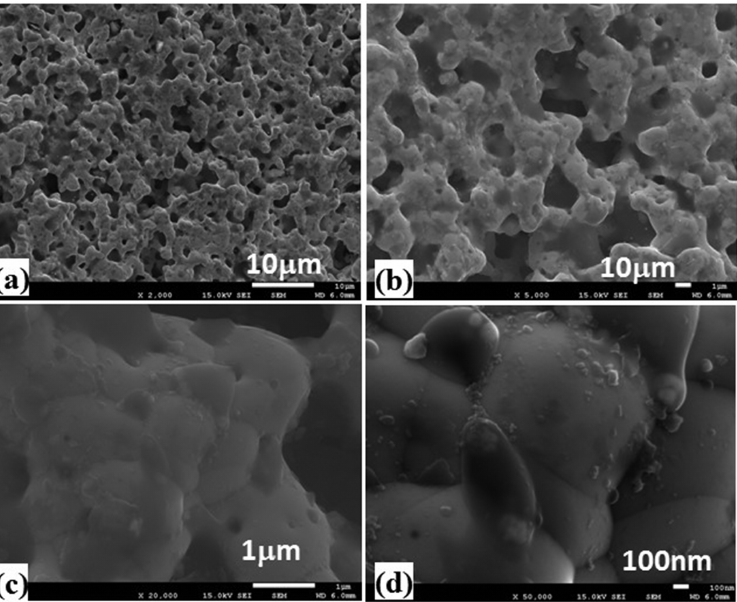
Figure 8: Surface of Pt cathode after experiment (maximum potential: 2.0 V).